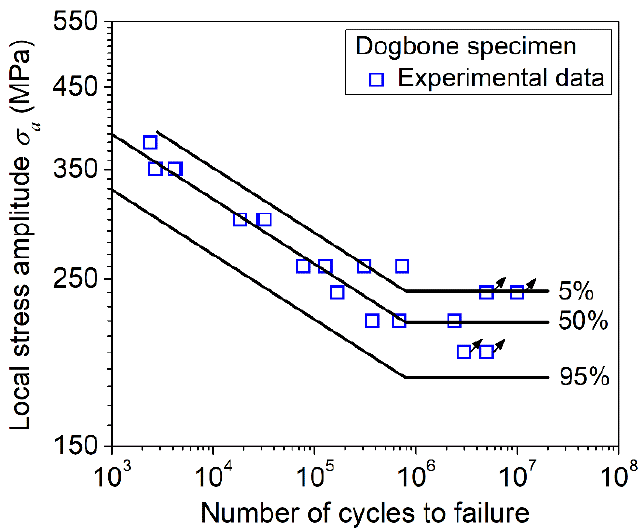
Figure 11. Comparison of predicted P-S-N curves with experimental data of dogbone specimens by using the experimental data of hourglass specimens, in which the arrows denote the unbroken specimens at the associated cycles.